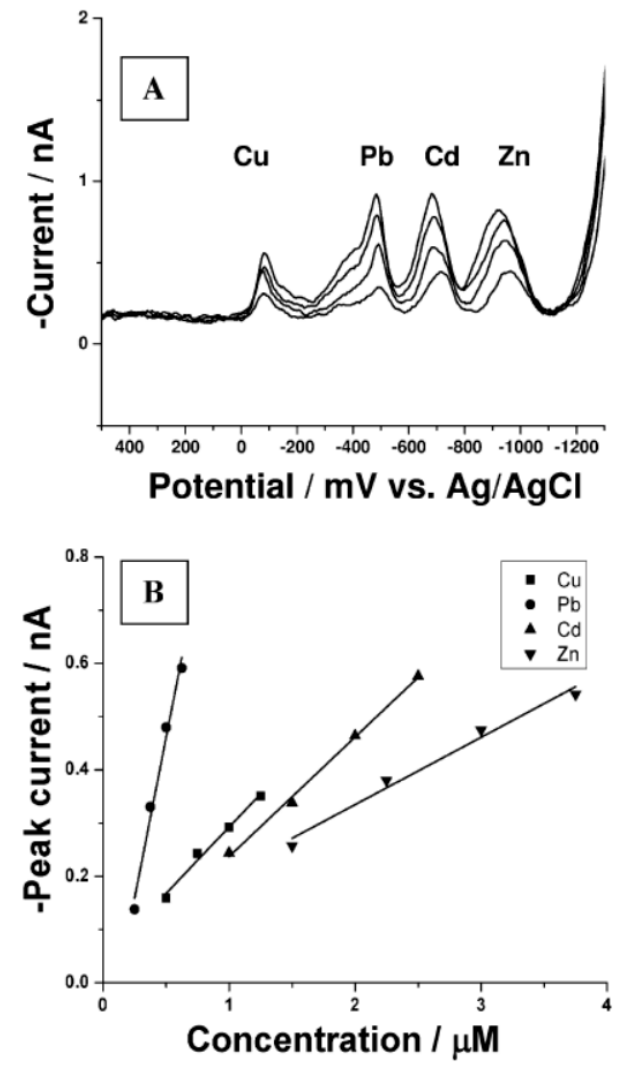
Figure 7. ( A ) Simultaneous detection of Cu(II), Pb(II), Cd(II) and Zn(II), ion concentrations 0.5, 0.25, 1.0, 1.5 μ M for Cu(II), Pb(II), Cd(II), Zn(II), respectively; and 1.5, 2, 2.5 times of above concentrations for these metals ions. ( B ) Calibration Curve for Cu(II), Pb(II), Cd(II), Zn(II). Accumulation time: 120 s, deposit potential: − 1.5 V. Reproduced from [129].